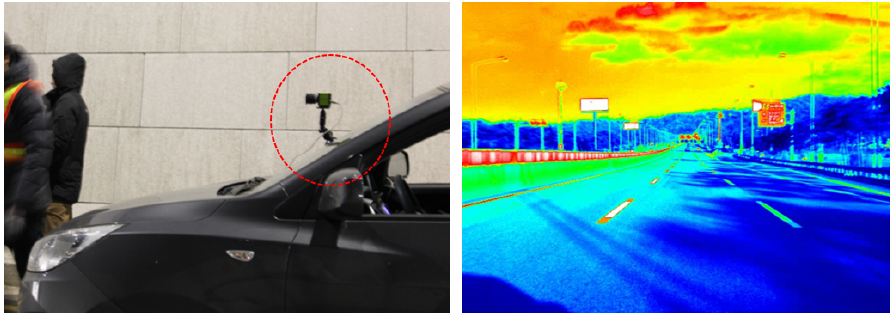
Figure 1. Example of a luminance camera setup and captured